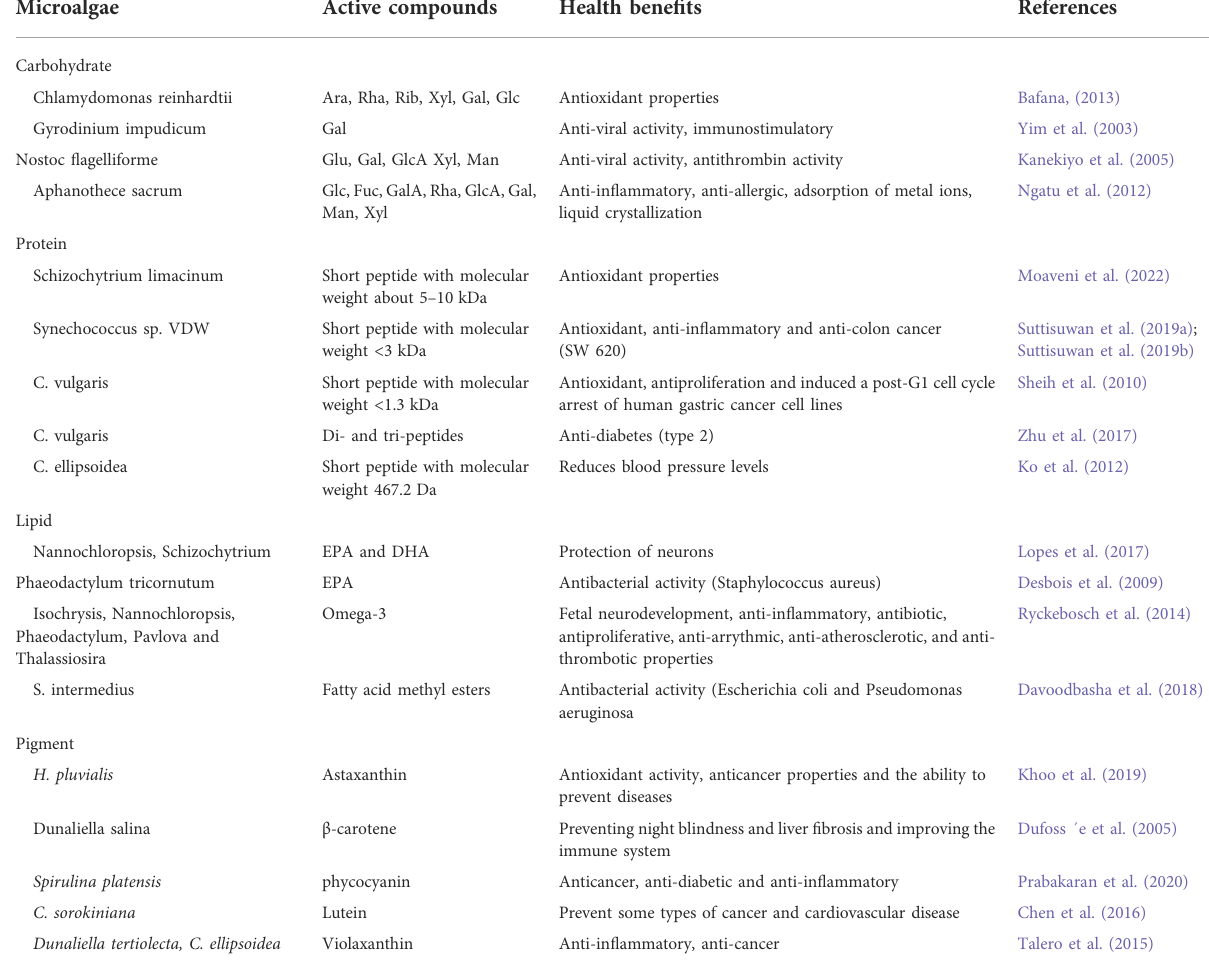
TABLE 2 Nutrient compositions in different microalgae species and their health bene fi